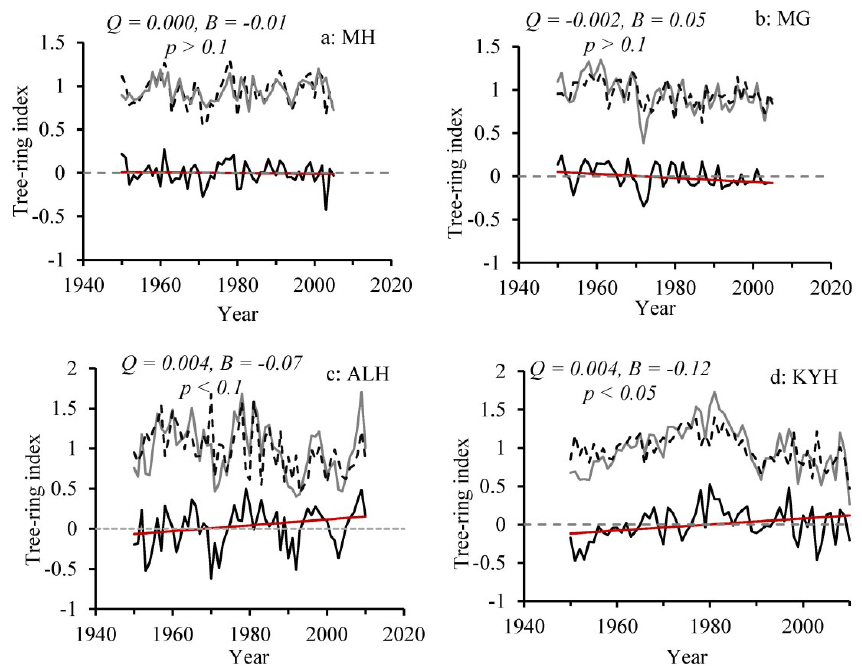
Figure 5. Raw growth indices (gray line), predicted growth indices (black dash line), and residual growth indices (black line), with Sen’s regression line (red line) superimposed for four sites; Q is Sen’s slope and B is a constant.